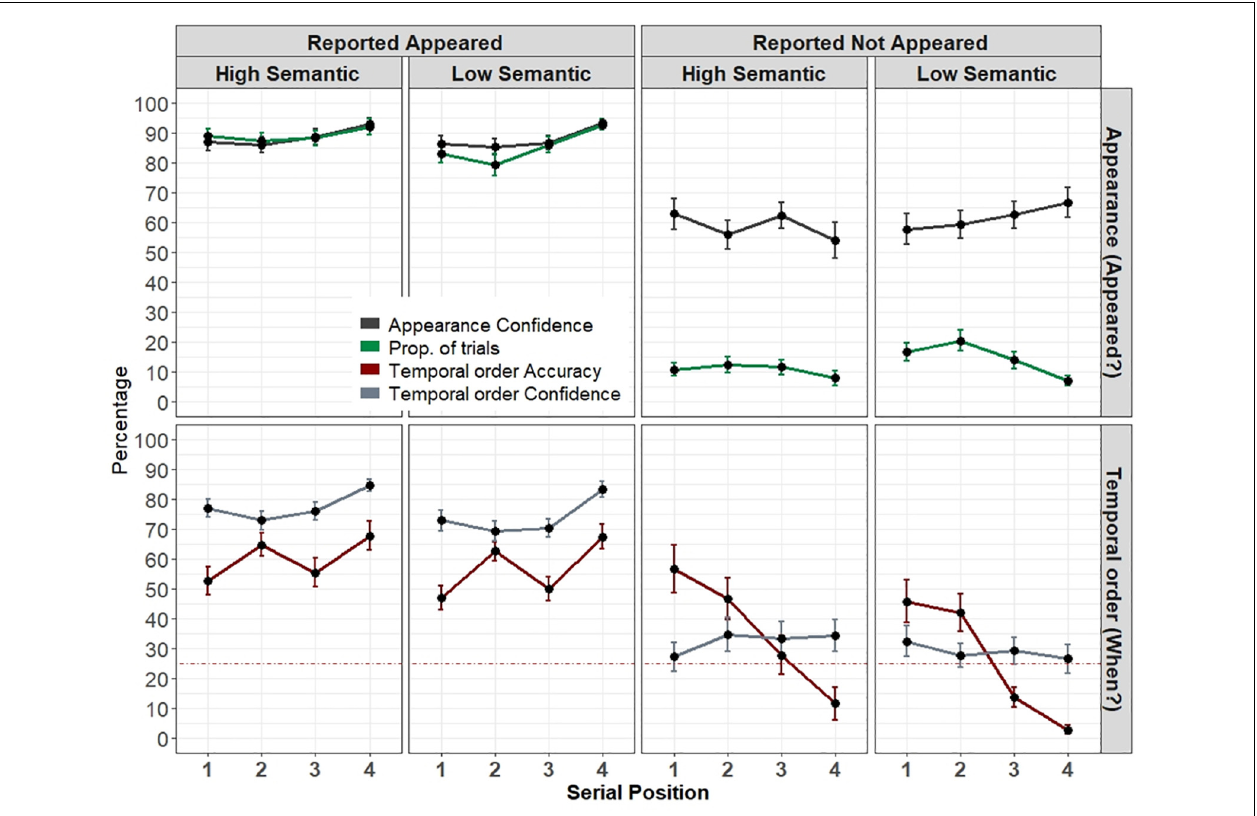
FIGURE 5 | Experiment’s 3 results. Top: Proportion of trials and appearance confidence as a function of semantic level, reported appeared or not, and serial position. Bottom: Percentage of correct temporal order responses and mean confidence rating as a function of the item’s semantic level, reported appeared or not, and serial position. The dotted line represents the 25% chance level. Error bars represent one standard error of the mean.